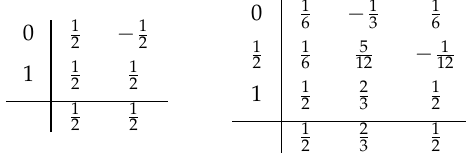
Table A1. The Lobatto3C methods of order two (left) and order four (right).